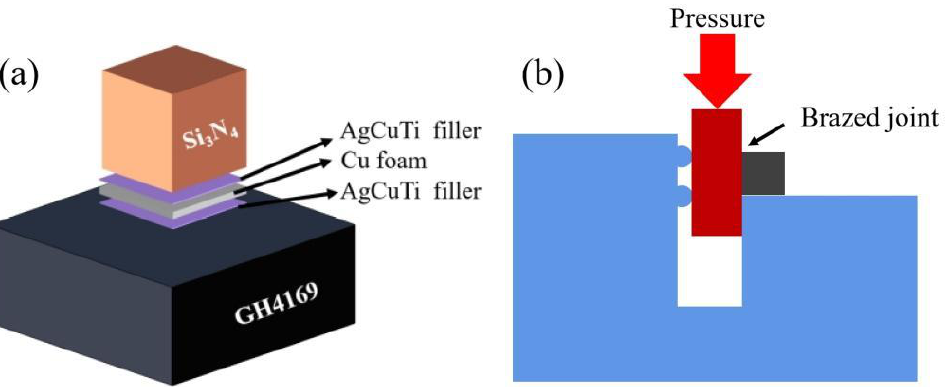
Figure 3. ( a ) Schematic diagram of sample assembly; ( b ) shear test.